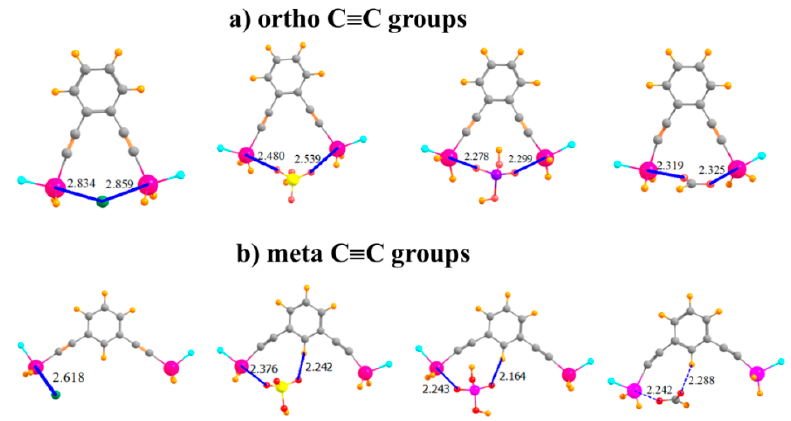
Figure 5. Of Cl − , HSO 4 − , H 2 PO 4 − , and HCOO − with -C ≡ C- extensions on ( a ) ortho and ( b ) meta positions of phenyl ring.